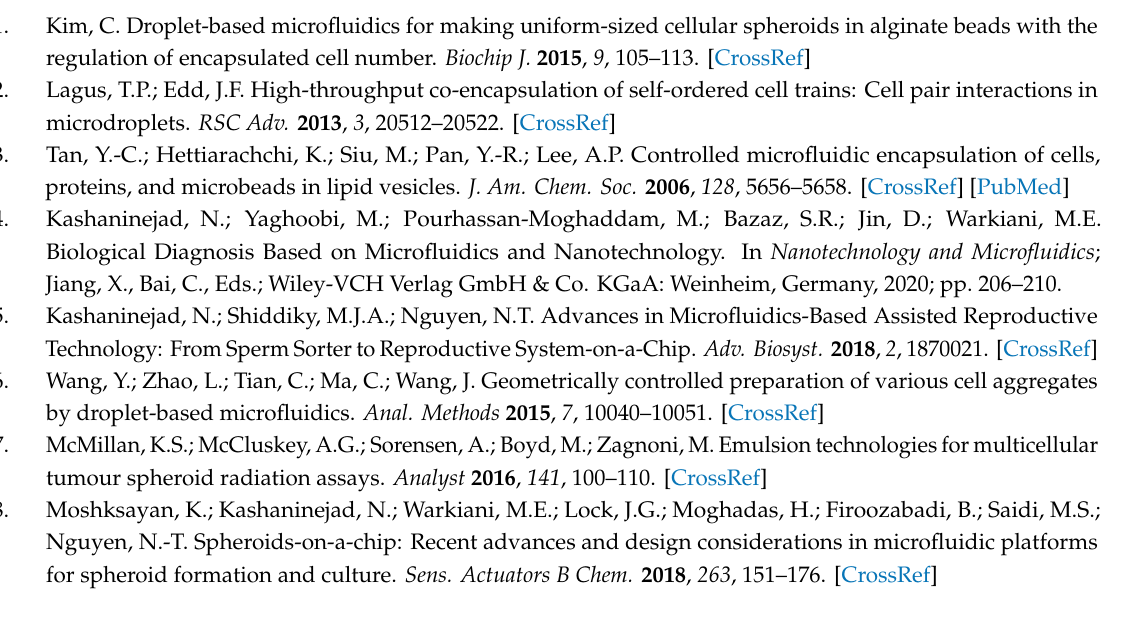
Figure S1: The meshes used for calculations in the midplane of the 3D domain. Figure S2: The variation between droplet diameters over 10 generation for σ = 0.043 N and θ wall = 75 ◦ in EF = 1.71. Once the e ff ect of initial m condition is damped, the variation in droplet generation regime becomes minimum and dripping regimes becomes stable. Figure S3. (a) Space-Time diagram of particles in the case of SD = 0 µ m, straight channel and EF = 1.71. First two droplets are forming while there is no cell available in the site of formation. (b) Maximum velocity of the whole domain which represents the time of droplet generation. (dashed green lines in time). If the maximum velocity of the whole domain is greater 4.5 m / s as a peak it will show the droplet generation. By the time that droplet is forming, if the cells x-location is greater than 270 µ m then they would end up in a droplet and be encapsulated. Blue and red balls on the top of the diagram show the resulting pair of the cells. Figure S4. (a) Space-Time diagram of particles in the case of SD = 10 µ m, spiral channel and EF = 1.71. First two droplets are forming while there is no cell available in the site of formation. (b) Maximum velocity of the whole domain which represents the time of droplet generation. (dashed green lines in time). If the maximum velocity of the whole domain is greater 4.5 m / s as a peak it will show the droplet generation. By the time that droplet is forming, if the cells x-location is greater than 270 µ m then they would end up in a droplet and be encapsulated. Blue and red balls on the top of the diagram show the resulting pair of the cells. Video S1: Unstable regime producing non-uniform droplets. Video S2: Increasing the downstream length to suppress the e ff ect of constant pressure at the outlet. Video S3: E ffi ciency of encapsulation is 100% for SD = 5 µ m. Video S4: E ffi ciency of encapsulation is 100% for SD = 5 µ m. Video S5: Encapsulation e ffi ciency decreases to 45% for SD = 10 µ m for spiral input. Video S6: Encapsulation for straight input of particles with SD = 10 µ